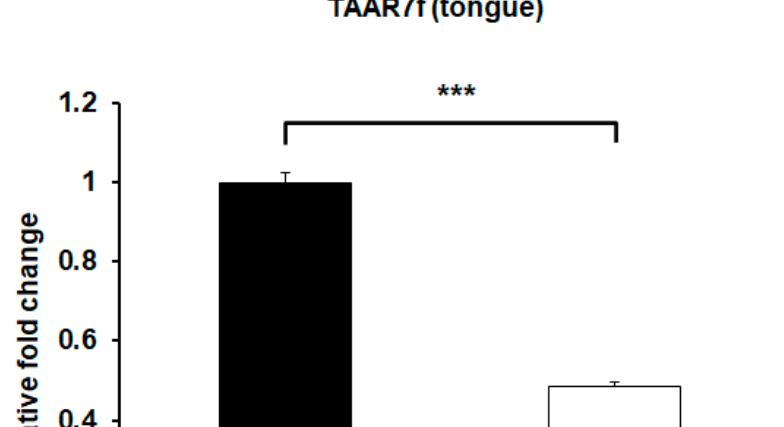
Table 1. DNA microarray analysis in blood sample.